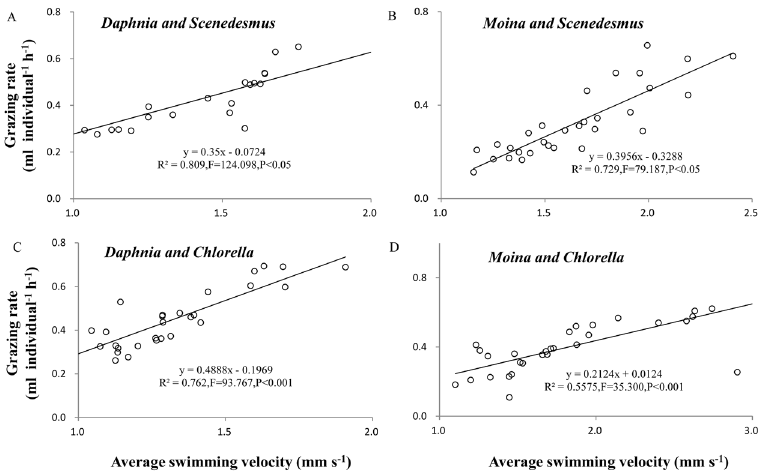
Fig 4. Linear regressions between average swimming velocity and grazing rate of grazer species in different algal-grazer systems. (A) Scenedesmus quadricauda - Daphnia magna , (B) S . quadricauda - Moina micrura , (C) Chlorella vulgaris - D . magna , and (D) C . vulgaris - M . micrura